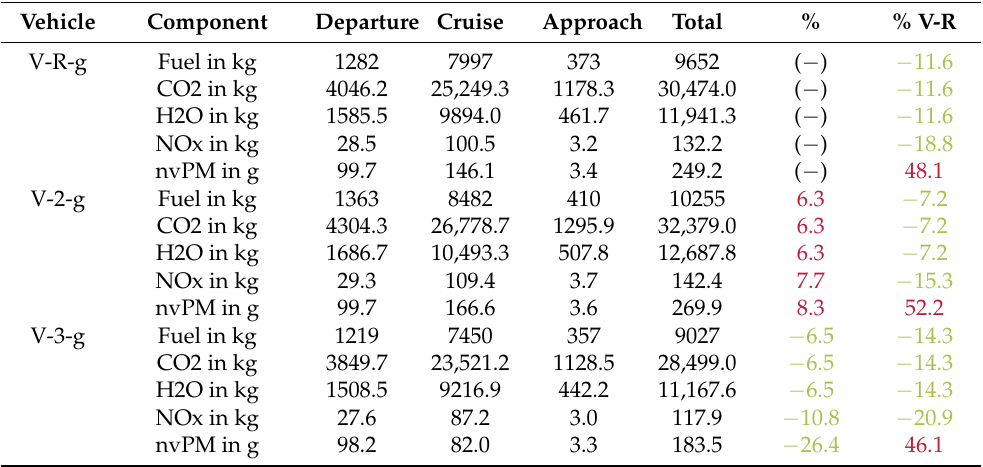
Table 6. Fuel consumption and emissions along the design mission ( neo ) and difference to the reference. Advantageous change: green, disadvantageous change: